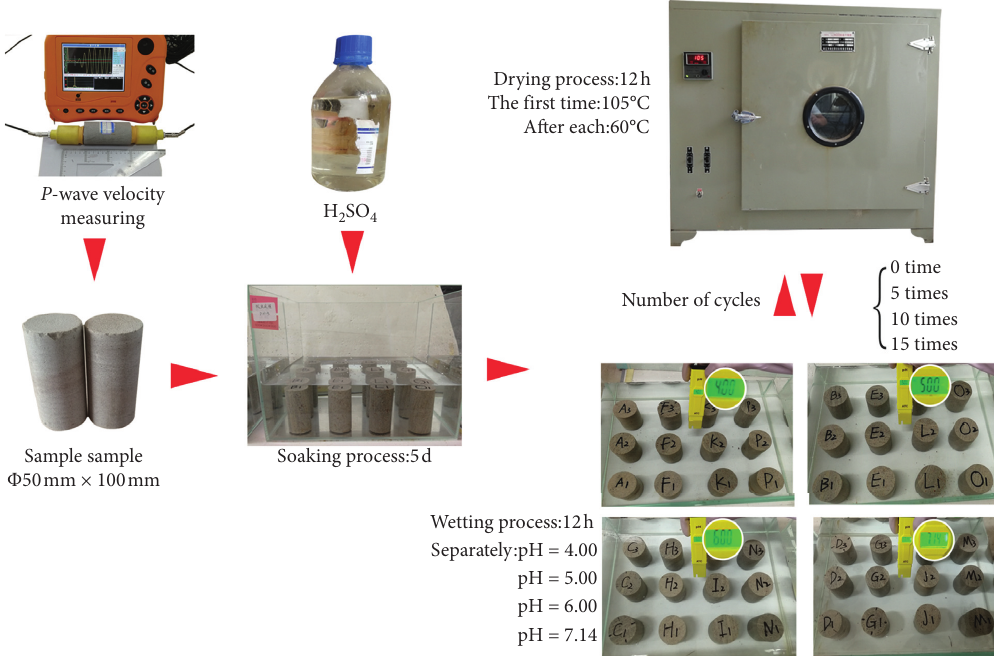
Figure 6: A-D-W cycle process. Table 3: Variation of sandstone specimen mass under different conditions.